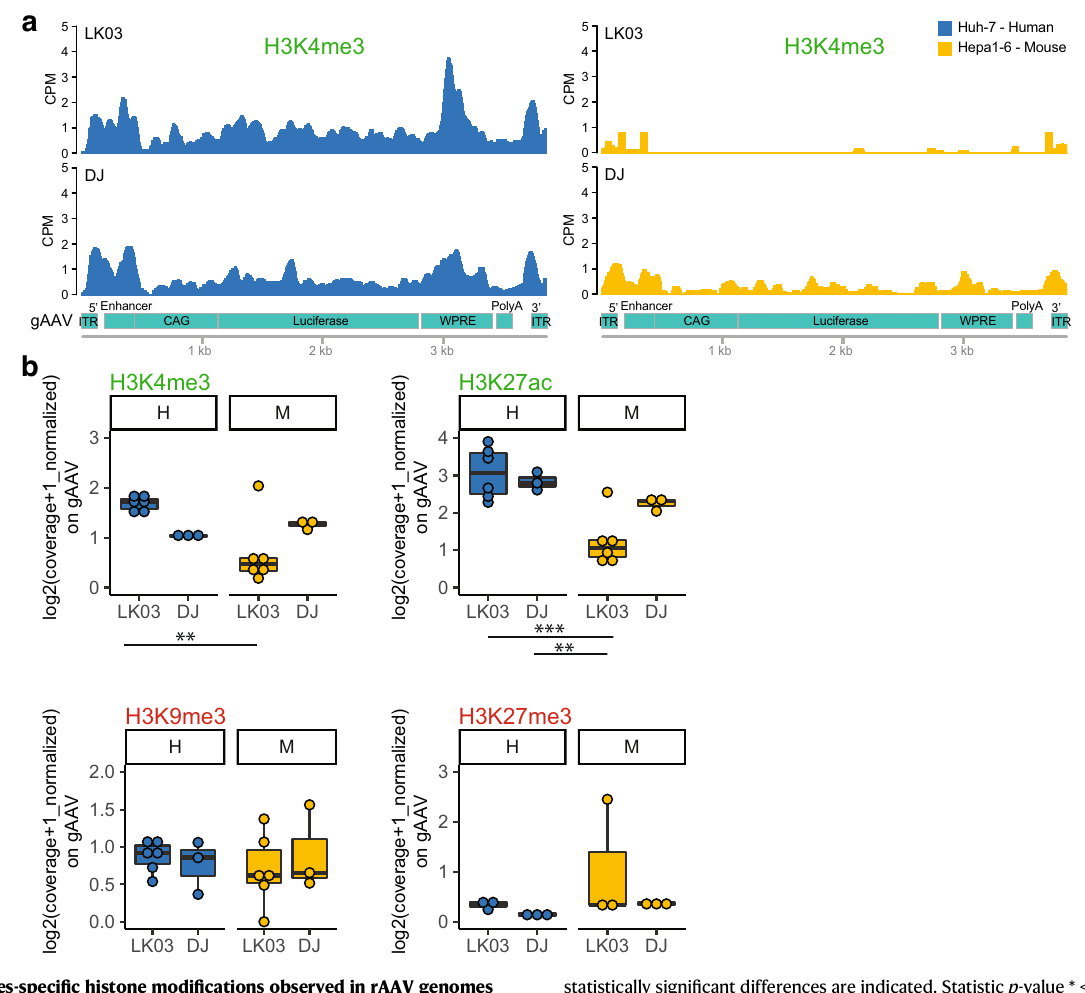
statistically signi fi cant differences are indicated. Statistic p -value * <0.05, **